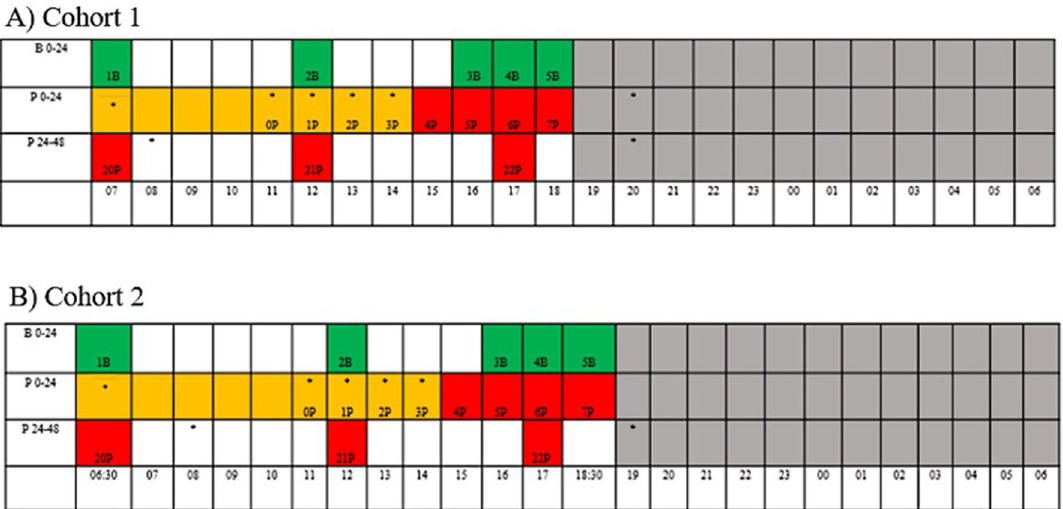
Figure 1. Overview of peri-operative observation and treatment of cynomolgus macaques. Twenty-four hour baseline (B 0–24) and 48 h post-surgery (P 0–24, P 24–48) video recording capture representation of cohort 1 ( A ) and cohort 2 ( B ). Cohort 1 day light cycle: 07:00 to 19:00; cohort 2 day light cycle: 06:30 to 18:30, dark phase indicated by grey squares. Every square represents an hour (unless indicated otherwise). Green squares